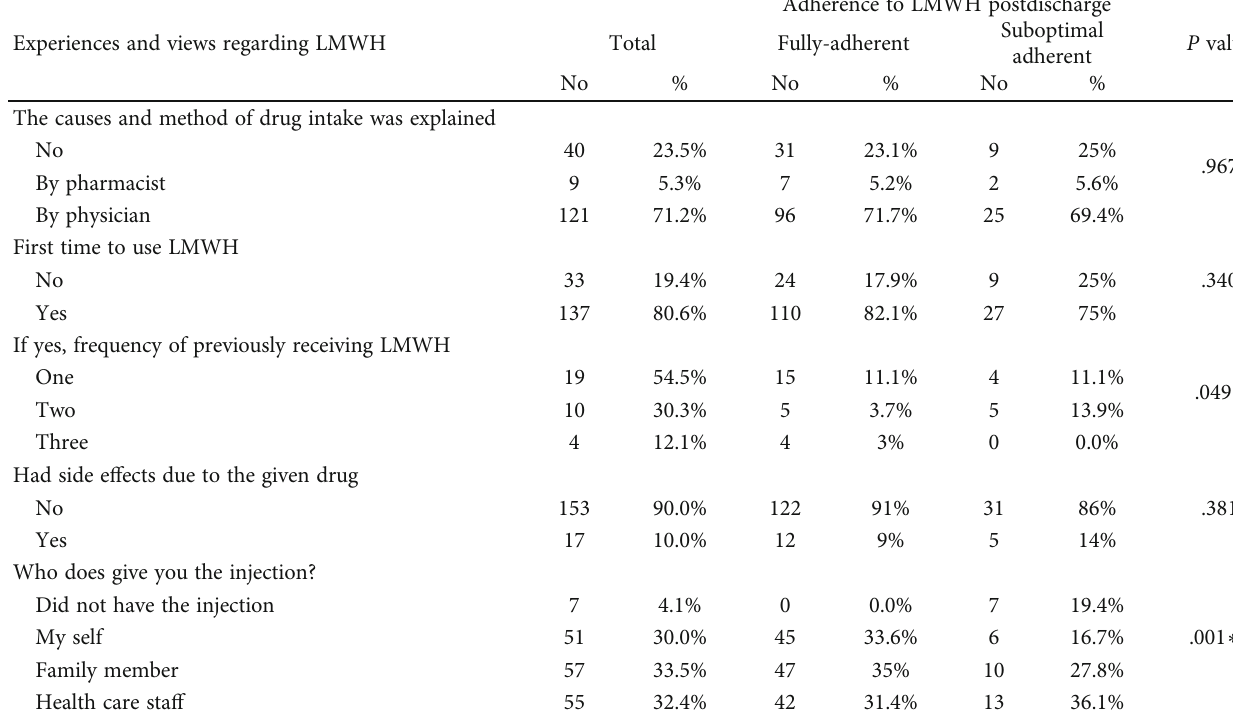
Table 5: Distribution of parturients ’ adherence to LMWH postdischarge by their experiences and views regarding LMWH. Experiences and views regarding